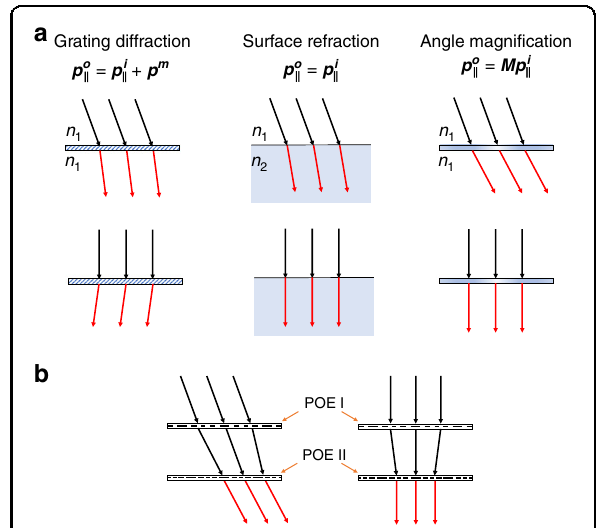
Fig. 1 Angle magni fi cation concept. a Schematic of light direction adjustment through grating diffraction, surface refraction, and angle magni fi cation. In the fi rst case, the grating adds a constant in-plane momentum component to the incident light independent of its incident angle. In the second case, upon surface refraction, the in- plane momentum component is conserved, but the output angle is scaled to the incident angle by Snell ’ s law. In the third case, for an ideal angle magni fi cation, the device adds an in-plane momentum component to the incident light with a fi xed scaling factor, and the input and output media are the same. b Illustration of a planar telescope consisting of two POEs for achieving angle magni fi cation. Both POEs have spatially variant in-plane momentum. POE II compensates the spatially variant in-plane momentum of light added by POE I. Together, they work as a grating with adaptive periods according to the incident angle. p o k in-plane momentum component of the output light, p i k in-plane momentum component of the incident light, p m in-plane momentum component of the grating, M magni fi cation factor, POE planar optical